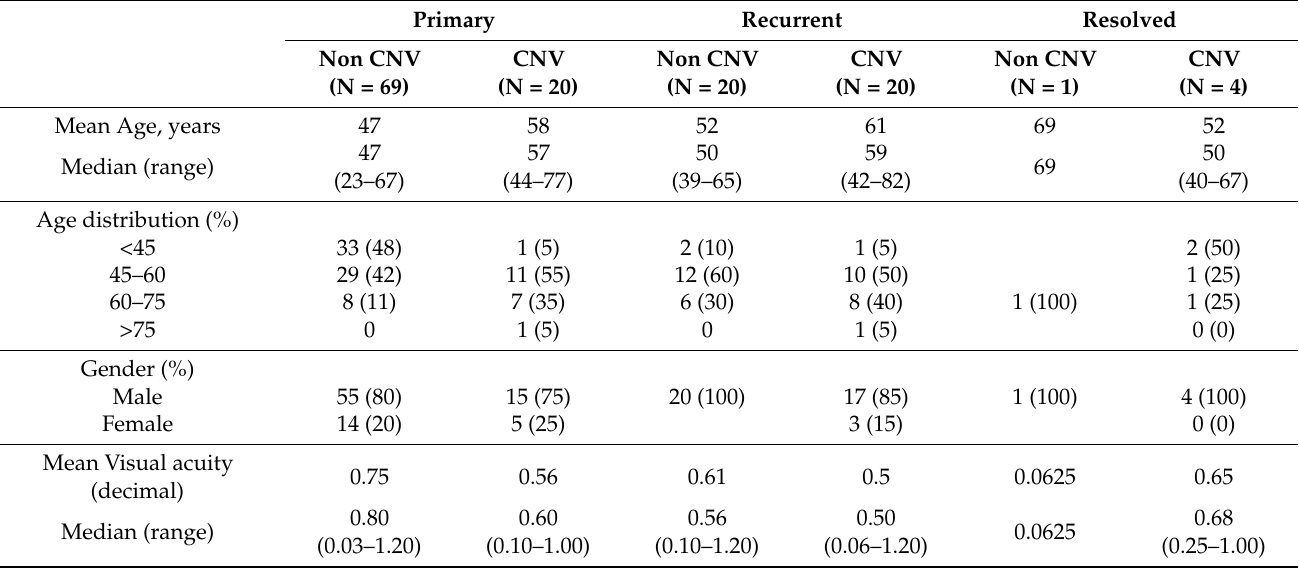
Table 4. Demographics of CNV and Non-CNV in Central Serous Chorioretinopathy: Onset Status Multimodal Imaging-Based Classification: Primary and Recurrent vs. Resolved.